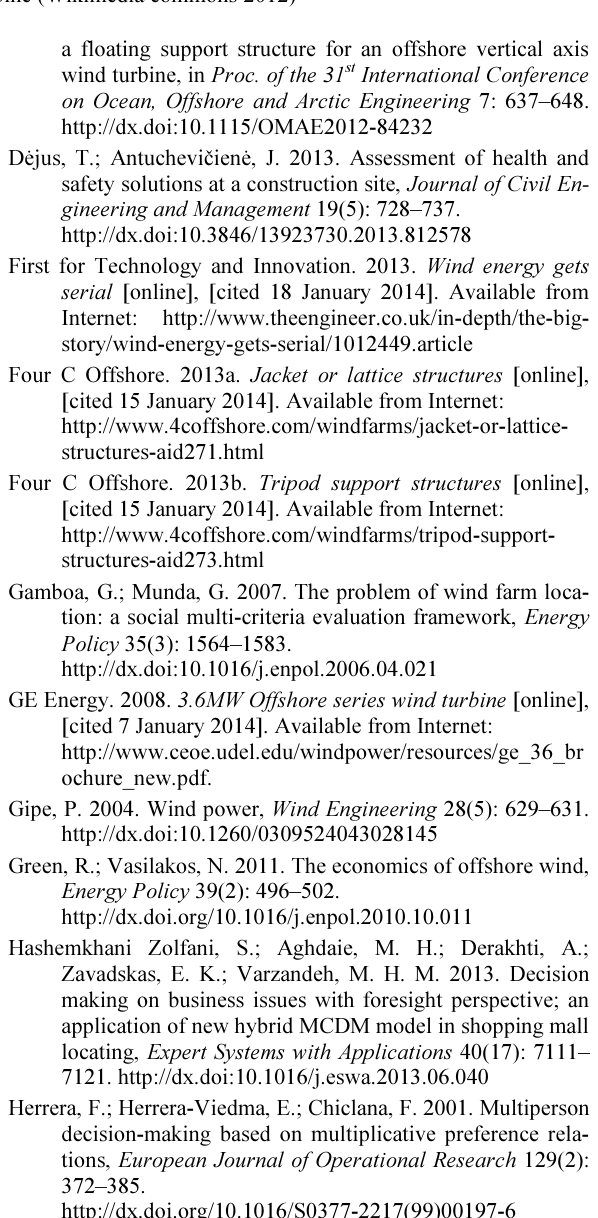
Fig. 3. REpower M5 5.0 MW Wind Turbine (Wikimedia commons